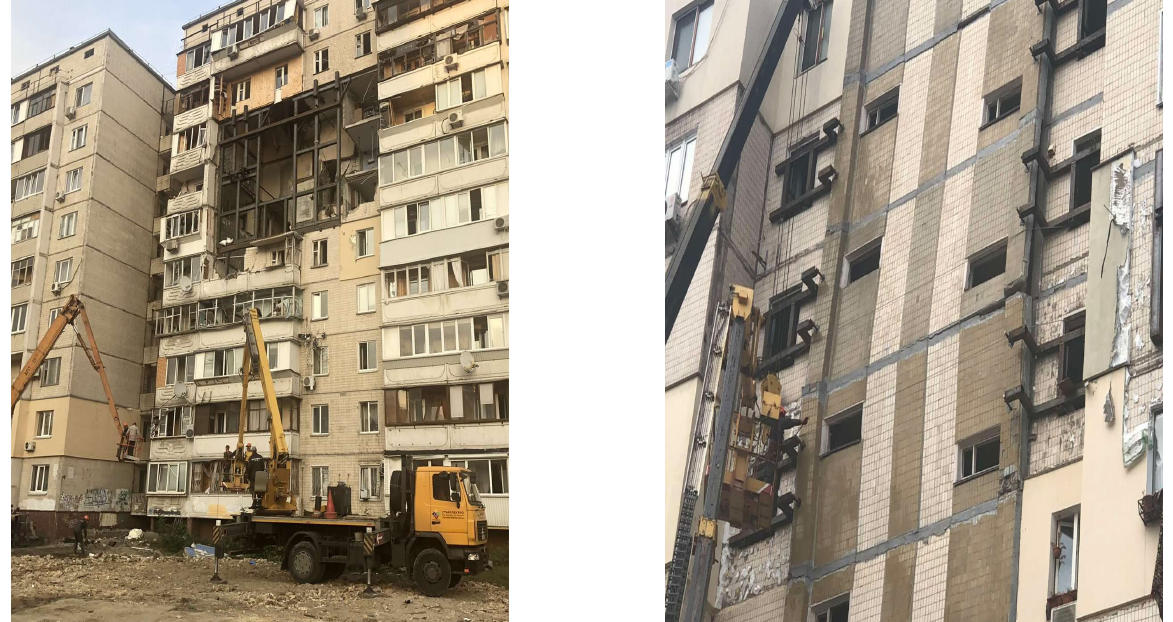
Figure 10. Urgent temporary stabilization of a large-panel building damaged as a result of a gas explosion (Kyiv city, S. Krushelnytska Street, June–October 2020).